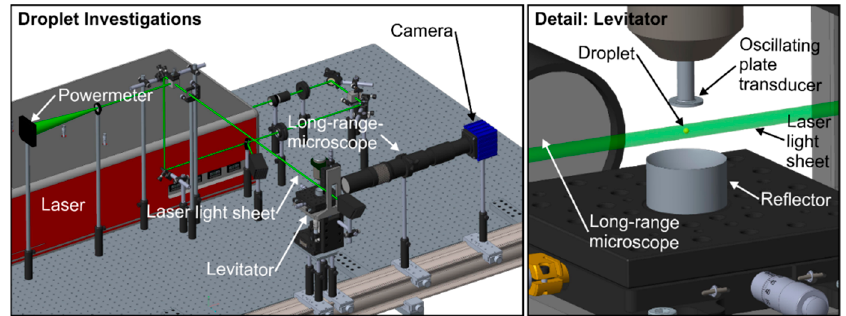
Figure 2. Optical setup ( left ) and detailed view of the levitator ( right ) for the droplet measurements.